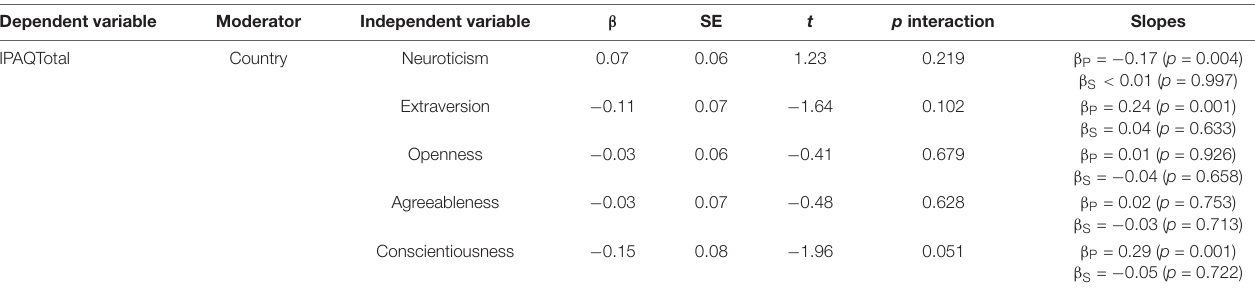
Vig, vigorous; Mod, moderate; r, Pearson’s correlation coefficient; p, significance; P, Poland; S, Spain. TABLE 3 | Moderation analysis–moderating variable: country; dependent variable: IPAQ total. Dependent variable Moderator Independent variable Slopes